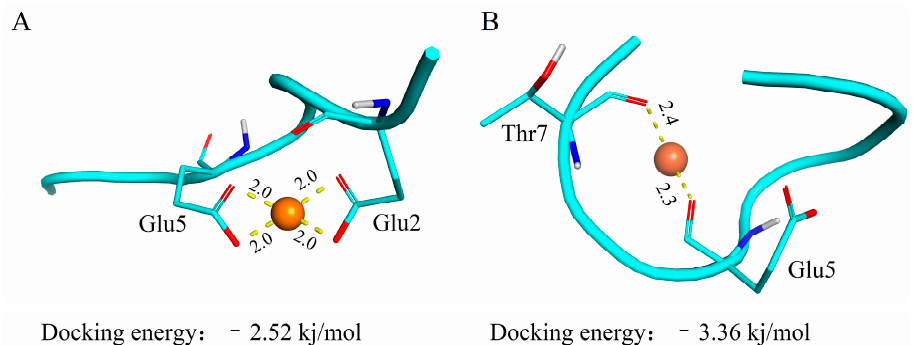
Figure 5. Molecular docking of iron-chelating peptides. ( A ) Interaction between Glu2 and Glu5 in peptide GEHIEESR with iron. ( B ) Interaction between Glu5 and Thr7 in peptide HAVSEGTK with iron. Note: The atoms represented by different colors are as follows: red: O; blue: N; white: H.